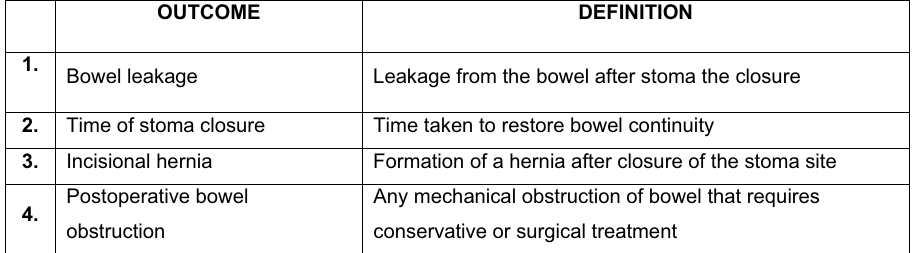
TABLE 3 - Outcome measurements relating to stoma